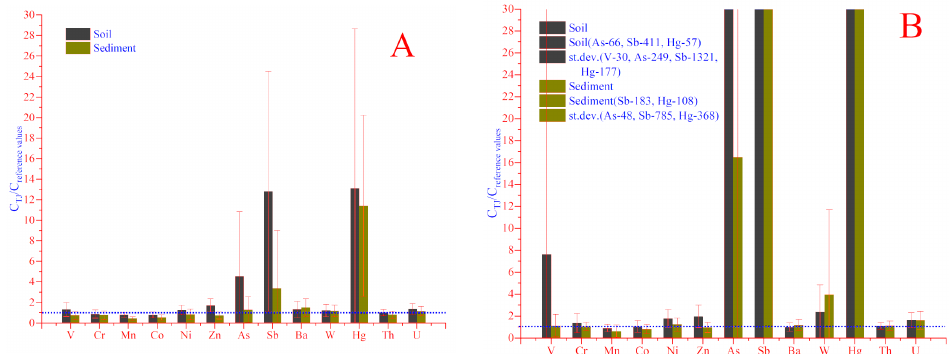
Figure 3. Normalized data of unexposed soil and sediment ( A ) samples, as well as soil and sediment exposed by anthropogenic impacts ( B ).